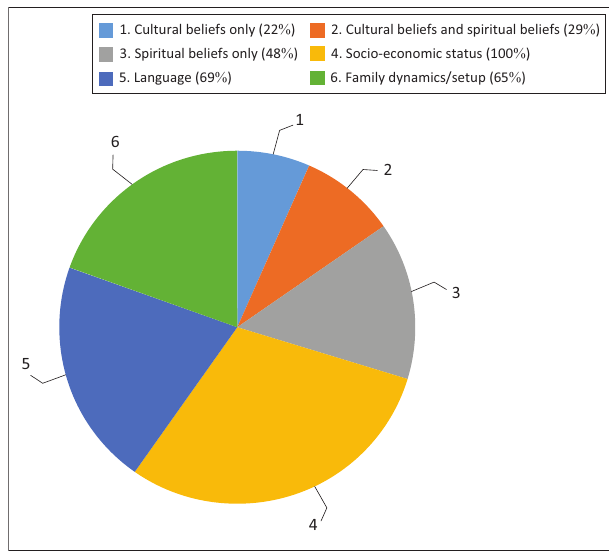
FIGURE 3: Aspects to consider during informational